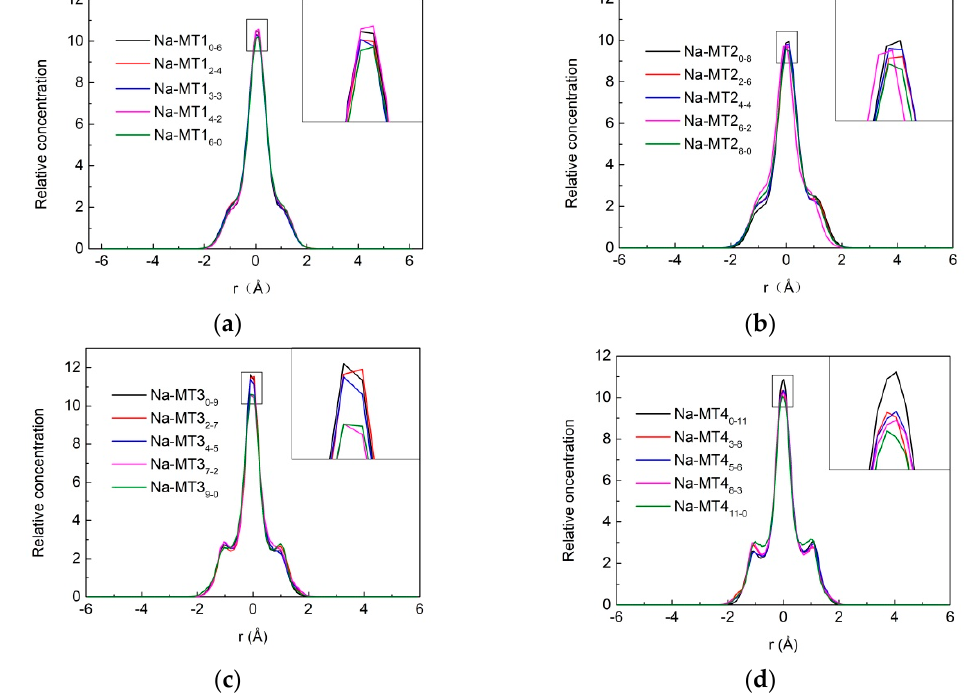
Figure 4. The z-axis concentration curves of H 2 O in interlayer of Na-MT with different isomorphic substitution sites, ( a ) Na-MT1; ( b ) Na-MT2; ( c ) Na-MT3; ( d ) Na-MT4.